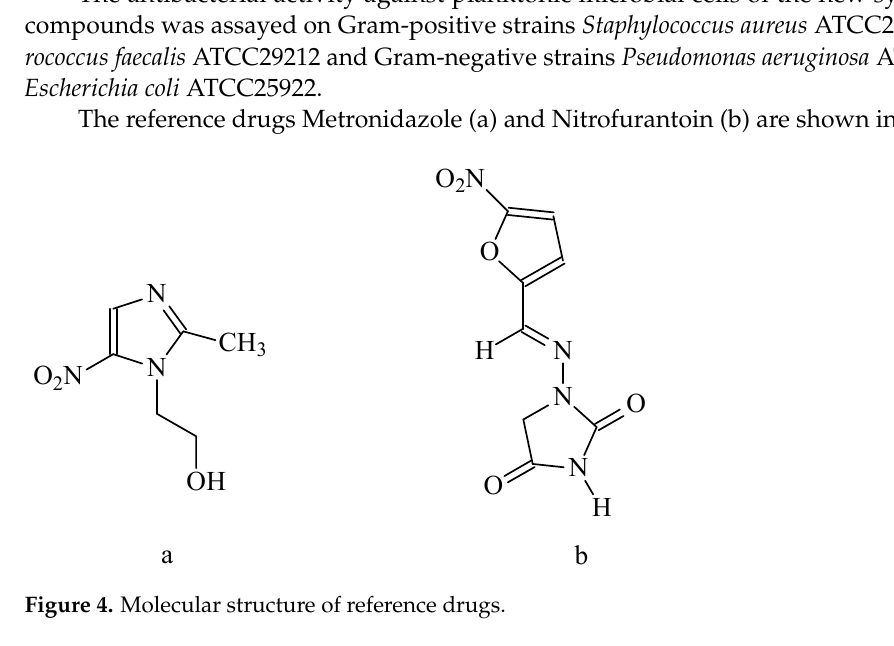
Figure 5. MIC ( μ g/mL) values of the tested compounds. Table 3. The minimum inhibitory concentration ( μ g/mL) of test compounds 5a–g . Compound